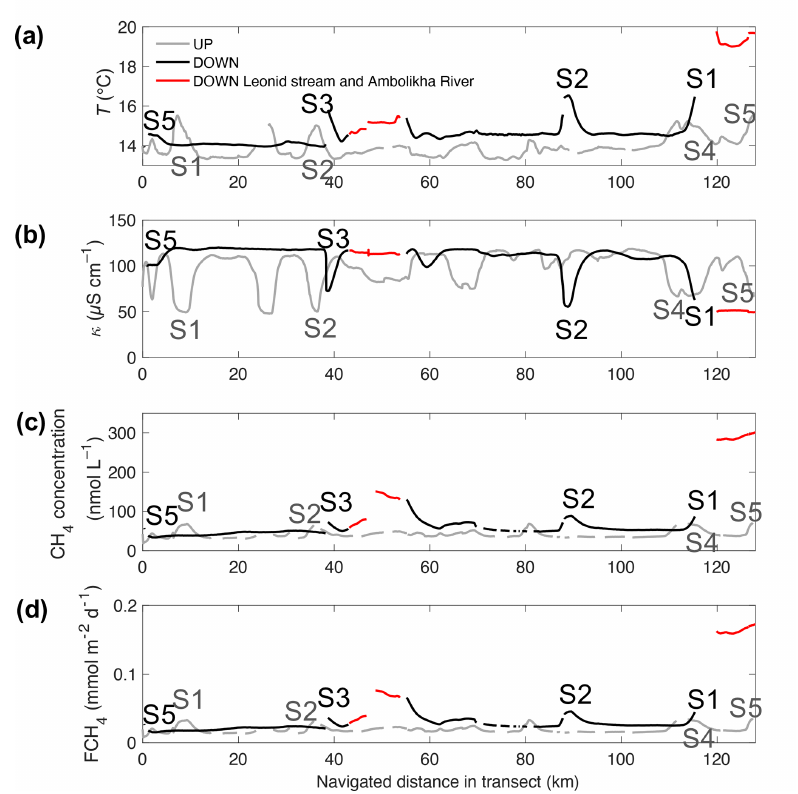
Figure 3. Water properties measured in transects UP (grey) and DOWN (black): (a) water temperature, T ; (b) water-specific conductivity, κ ; (c) CH 4 concentration, C w ; and (d) flux density of CH 4 , F CH 4 – all shown as a function of the navigated distance (km) along each transect. The location corresponding to the key sites S1 to S5 are indicated and color-coded in each signal (light grey – UP transect and black – DOWN transect). The Ambolikha River and Leonid’s stream are shown in red. Gaps in the data indicate erroneous or not measured data in the